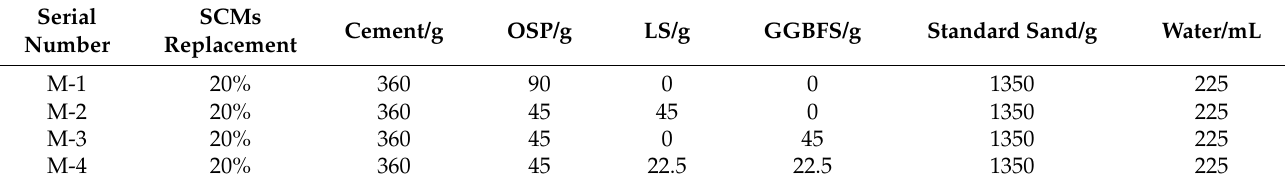
Table 3. Cement mortar ratio of group M.